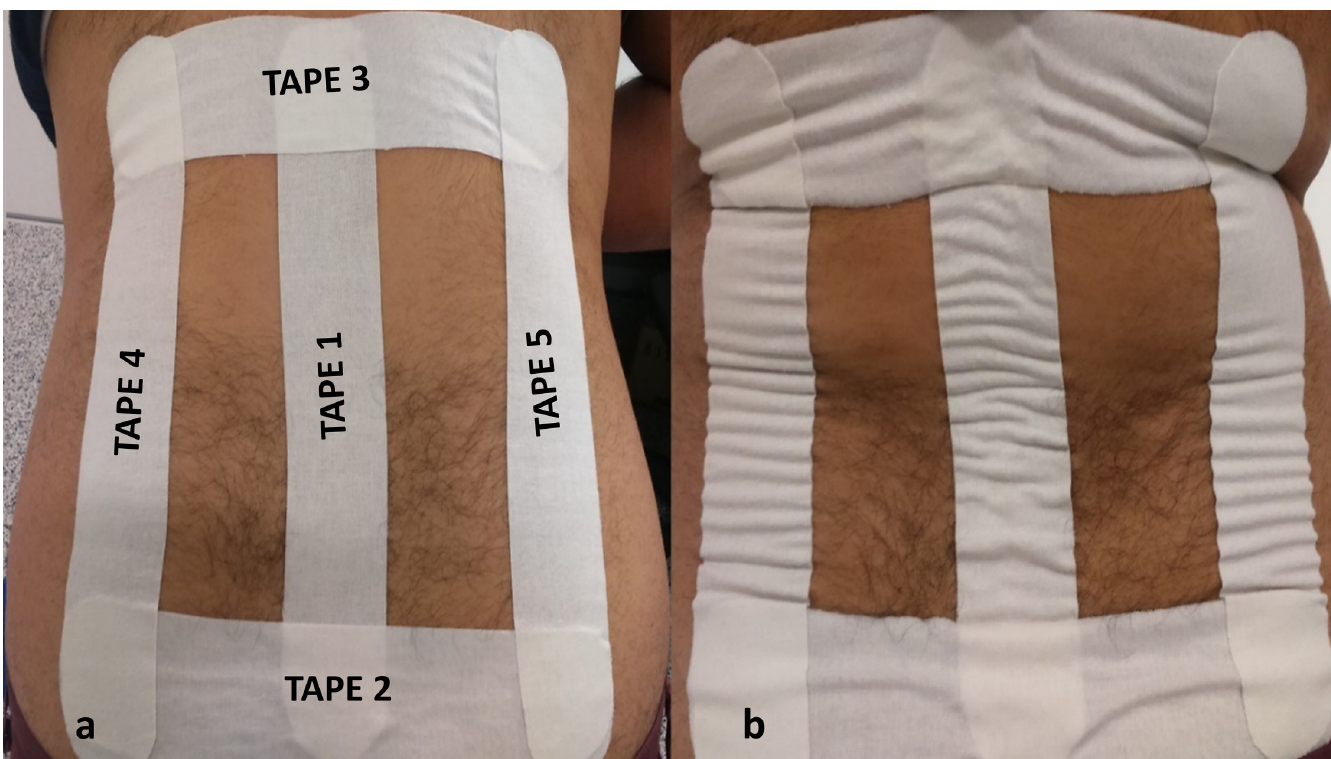
Fig 4. Image showing application of five strips of kinesiology tape to the skin of the lower back with the participant (a) leaned forwards, and (b) standing straight (with visible convolutions of skin upon kinesiology taping). Tape 1 was applied vertically long the spine from points 3 (~L4-L5 vertebrae) to 4 as marked in Fig 1. Tape 2 was applied horizontally along the left and right superior iliac crests corresponding to the imaginary intercristal line from points 1 to 2 as marked in Fig 1. Tape 3 was applied horizontally in the direction from right to left overlapping the upper end of Tape 1 in the region of mid-thoracic spine. Tapes 4 and 5 were applied vertically adjoining the upper and lower borders formed by the left and right ends of the two horizontal Tapes 2 and 3, respectively.